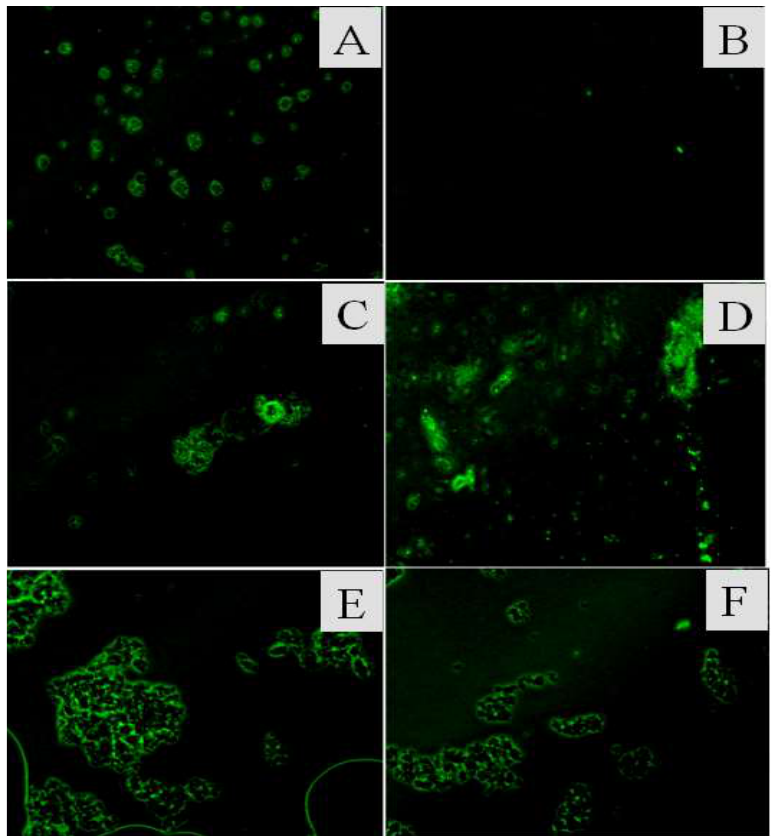
Figure 9. Confocal microscope images of CAT/ZIF-8, Fe 3+ -TA@CAT/ZIF-8, and SiO 2 @CAT@ZIF-8. ( A , C , E ) before acid treatment; ( B , D , F ) after acid treatment.